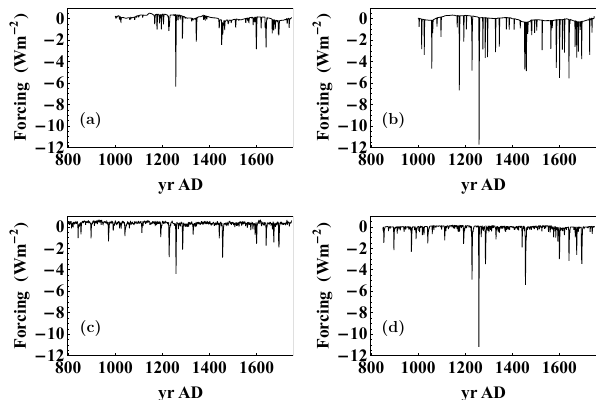
Figure 1. The different forcings used as input to the response model: (a) Crowley forcing used with the Moberg reconstruction and the ECHO-G simulation, (b) forcing used in the COSMOS ex- periment, (c) in the LOVECLIM experiment and (d) in the HadCM3